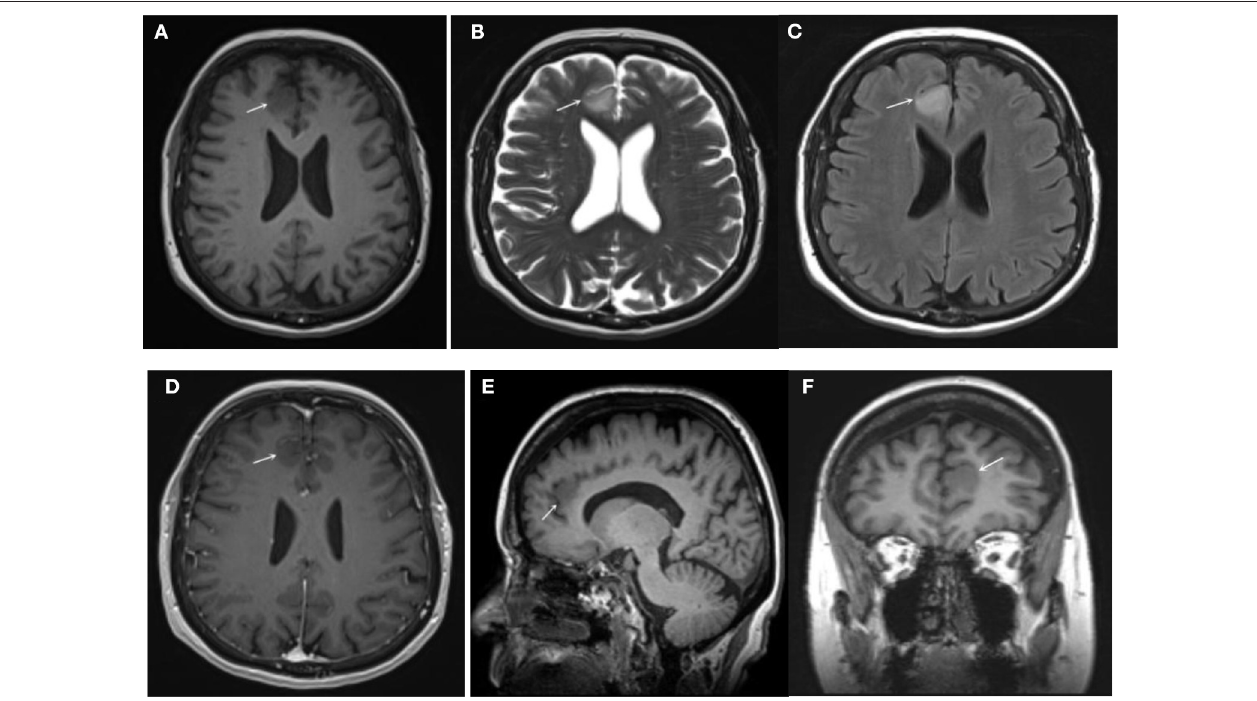
FIGURE 1 | IDH1 mutated glioma (low grade): (A) T1WI (B) T2WI (C) FLAIR (D) T1 + C (axial) (E) T1 + C (sagittal) (F) T1 + C (coronal). The lesion had a clear border, homogeneous signal intensities on T1WI and T2WI, as well as on FLAIR. The lesion presented mild homogeneous enhancement on post-contrast T1WI.